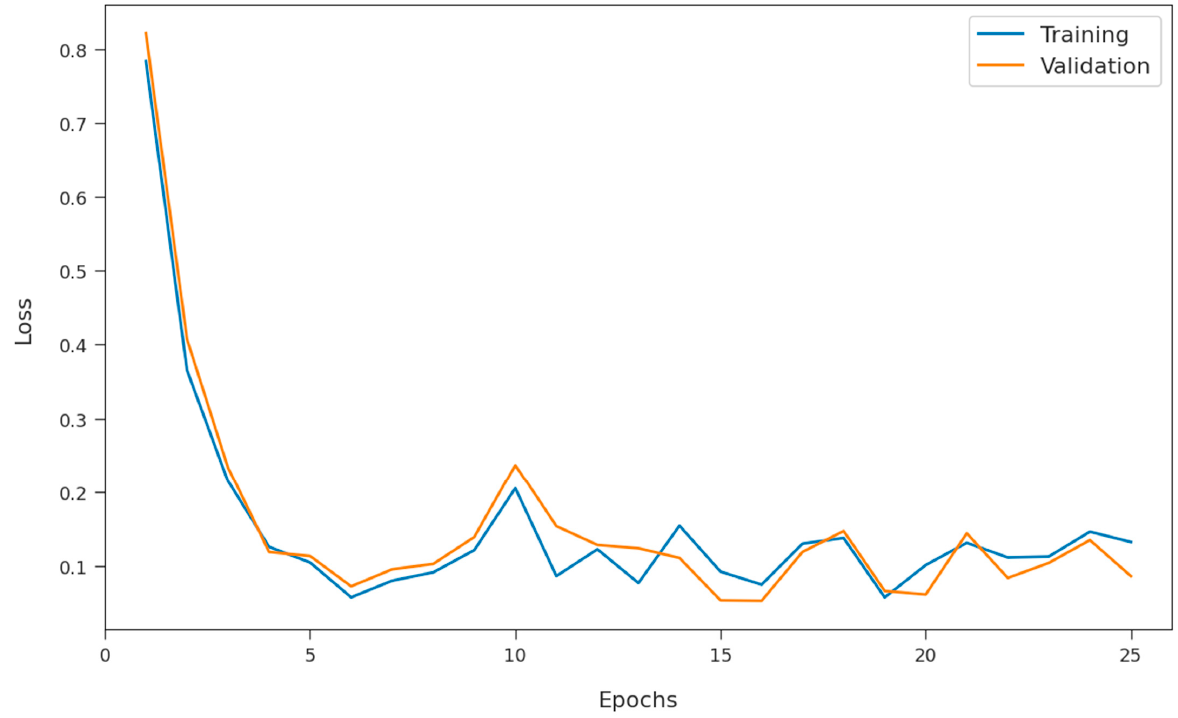
Figure 12. TL and VL analyses of SFODLD-SAC technique.